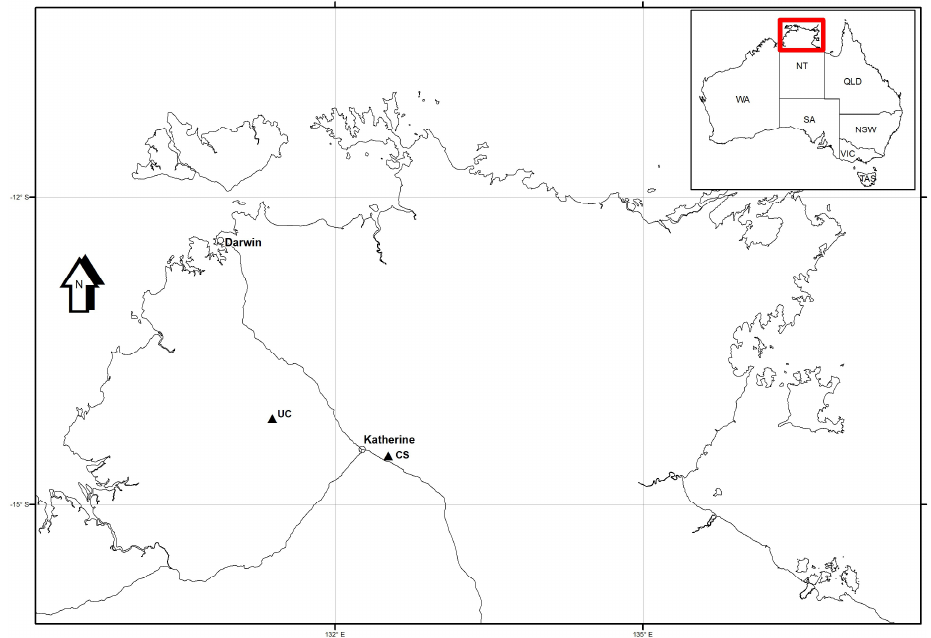
Figure 1. Location of the uncleared site (UC) and the cleared savanna (CS) sites south of Darwin, Northern Territory. The inset figure shows the distribution of the savanna biome across northern Australia as defined by Fox et al. (2001).